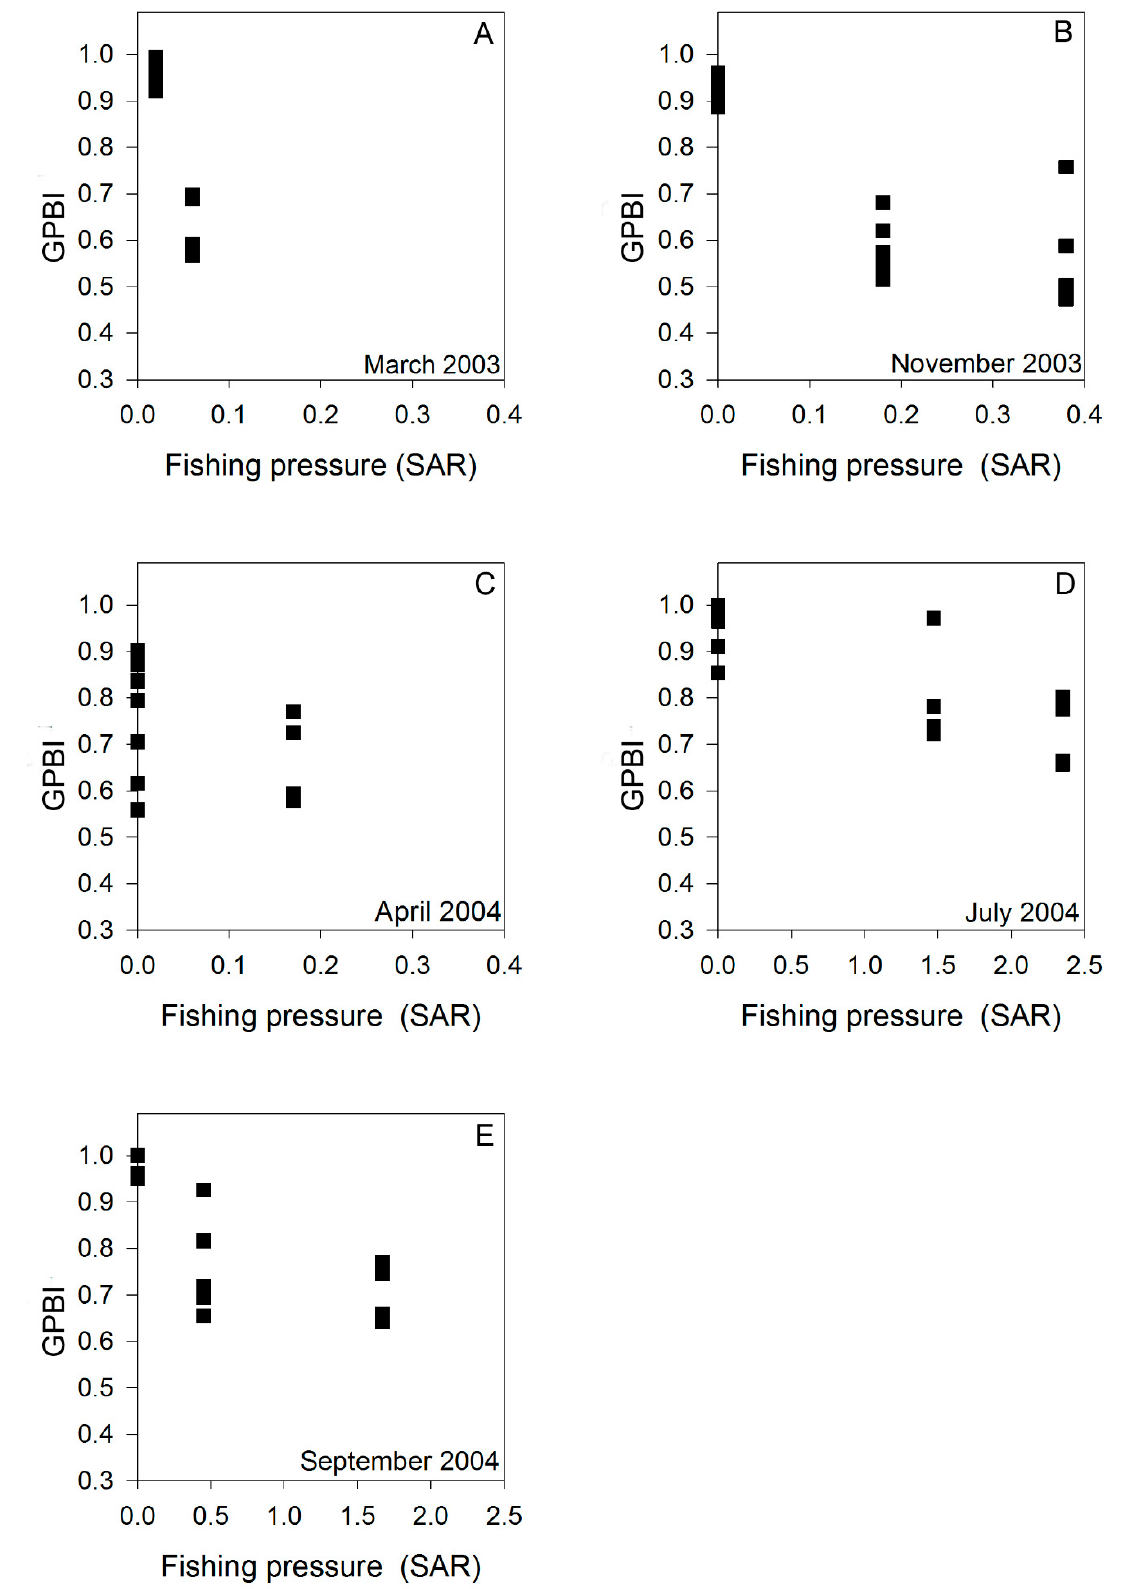
Figure 4. Case Study 3—trawling pressure (Germany, North Sea). Relationship between the fishing pressure (SAR, times trawled month − 1 ) and the GPBI for the stations located in two fishing areas and the unfished area in the German Bight (North Sea)( A ) in March 2003, ( B ) in November 2003, ( C ) in April 2004, ( D ) in July 2004 and ( E ) in September